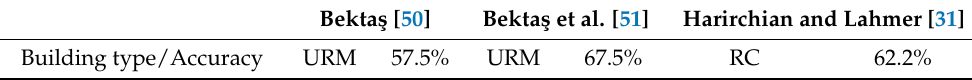
Table 6. Comparison of the developed S-RVS method with the